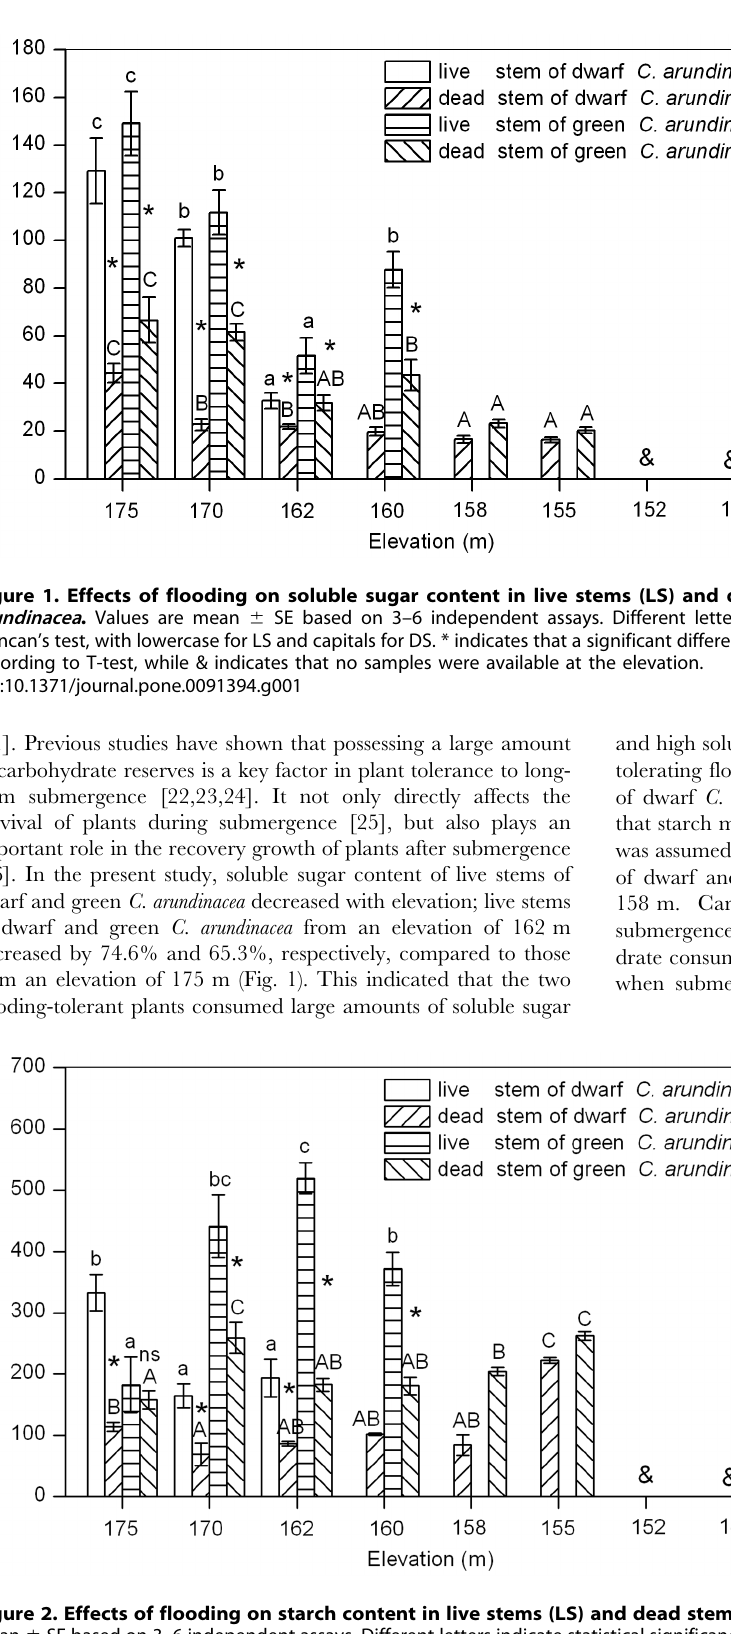
Figure 2. Effects of flooding on starch content in live stems (LS) and dead stems (DS) of dwarf and green C.arundinacea . Values are mean 6 SE based on 3–6 independent assays. Different letters indicate statistical significance ( P , 0.05) according to Duncan’s test, with lowercase for LS and capitals for DS. ns indicates that no significant differences occurred between starch content of LS and DS, while * indicates that a significant difference occurred between starch content of LS and DS according to T-test and & indicates that no samples were available at the elevation.